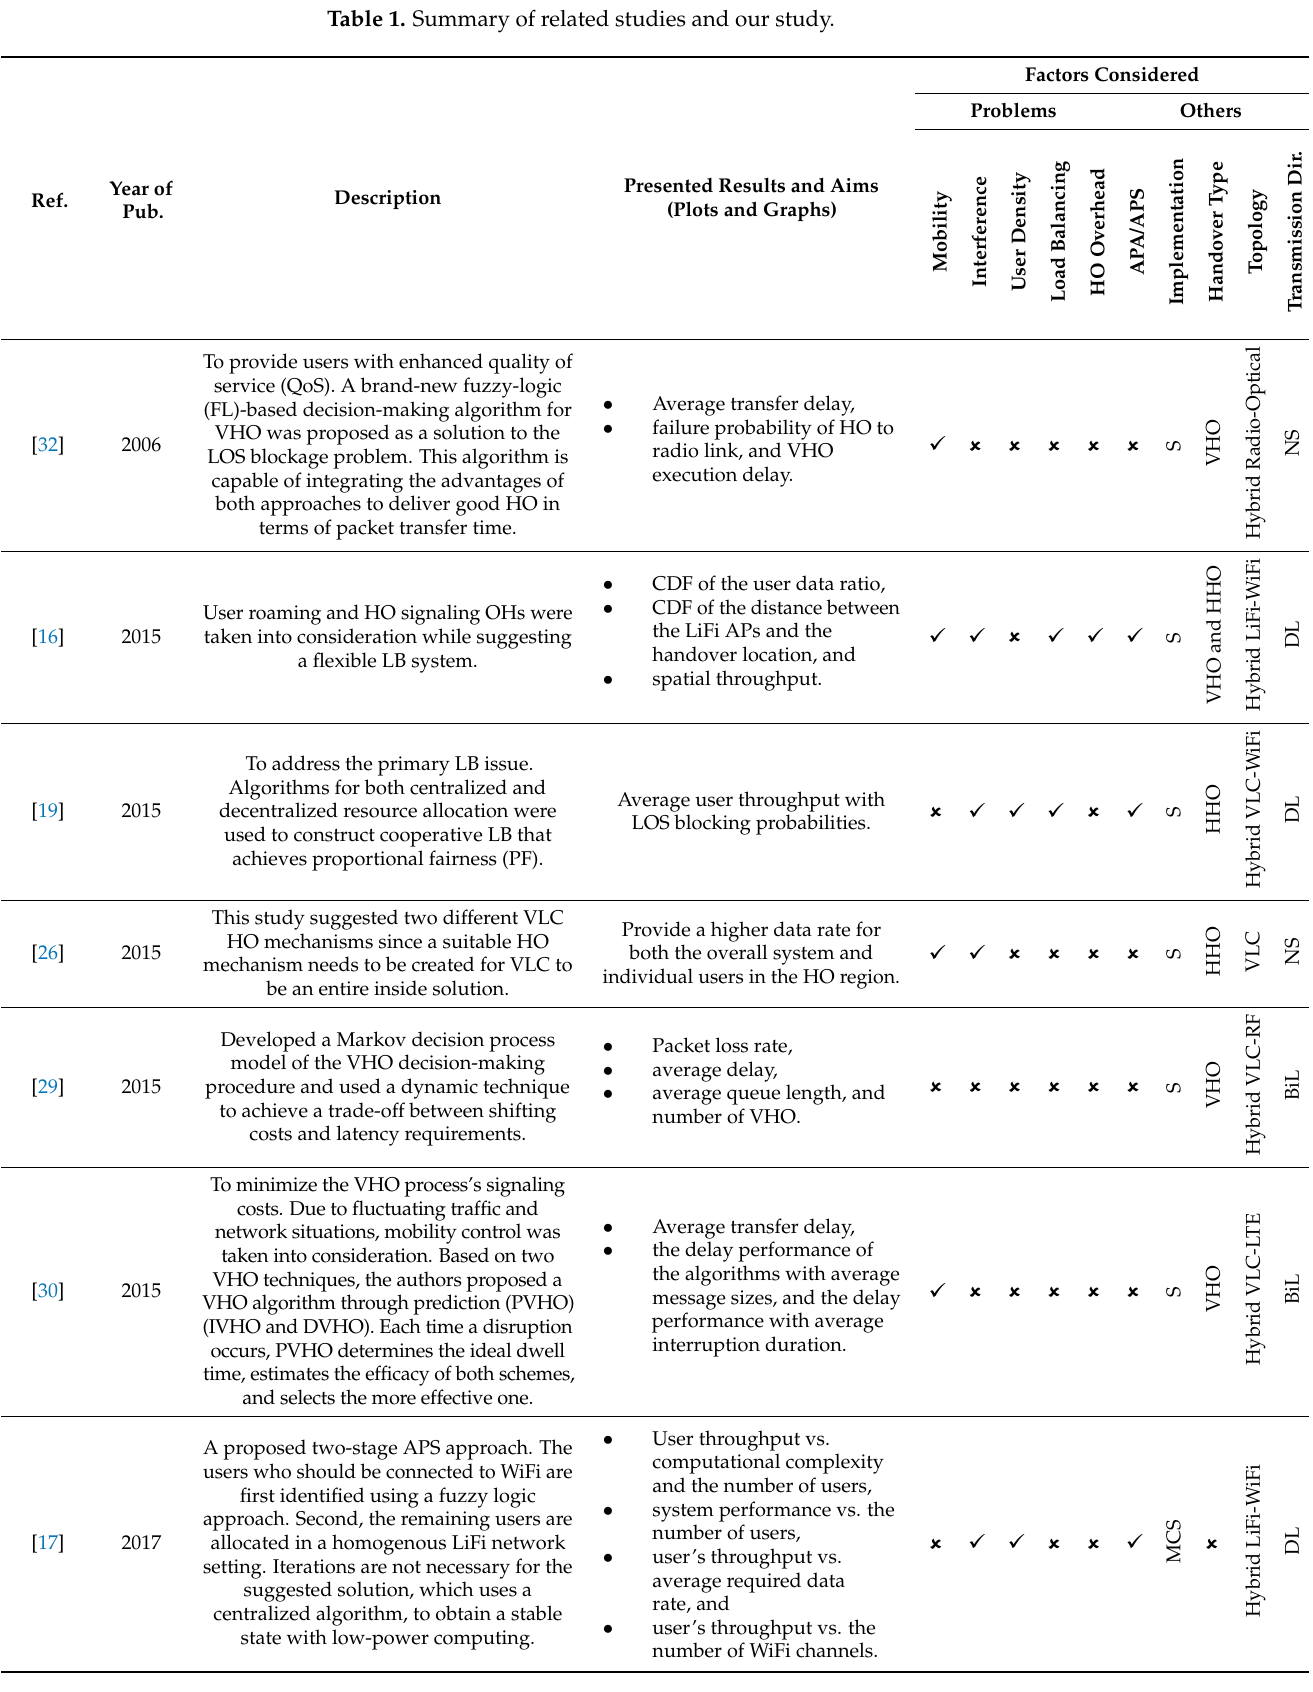
Table 1. Summary of related studies and our study.